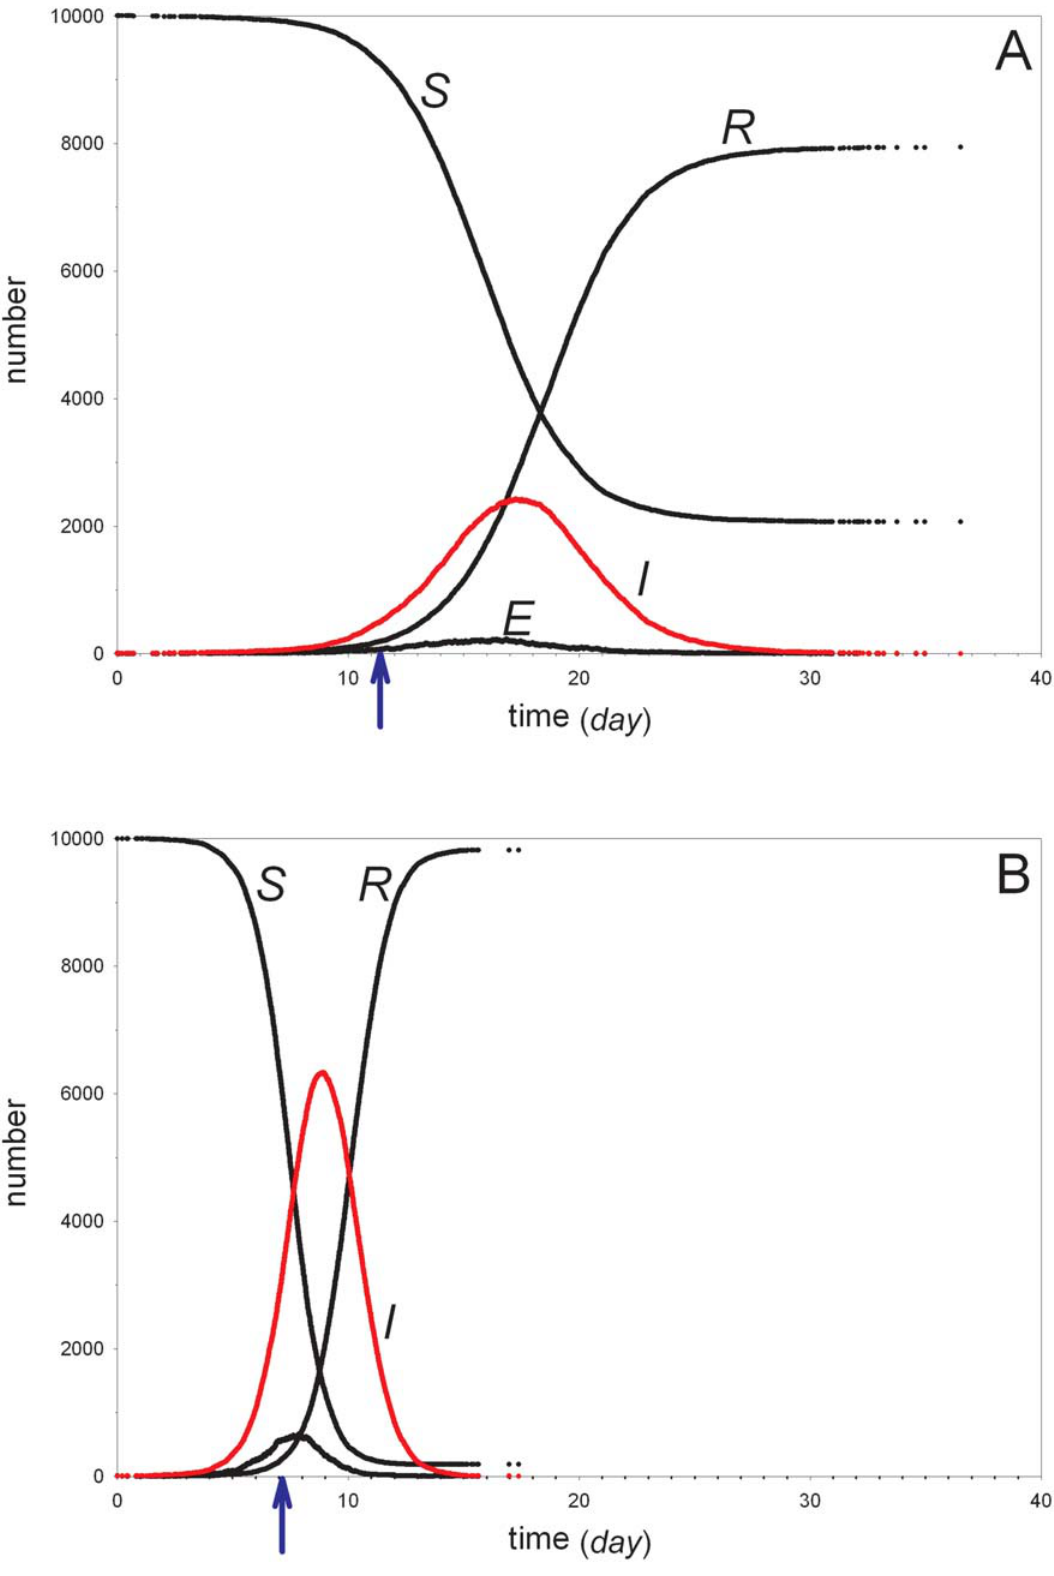
Figure 4. Simulations of an epidemic in a population of 50,000 birds. Parameters values are based on the estimates of Table 4 (scenario A1). A dot is plotted for the population state after each tenth event. (A) transmission parameter as in Table 4 (0.8 ( day 2 1 )) and (B) transmission parameter increased twofold (1.6 ( day 2 1 )).